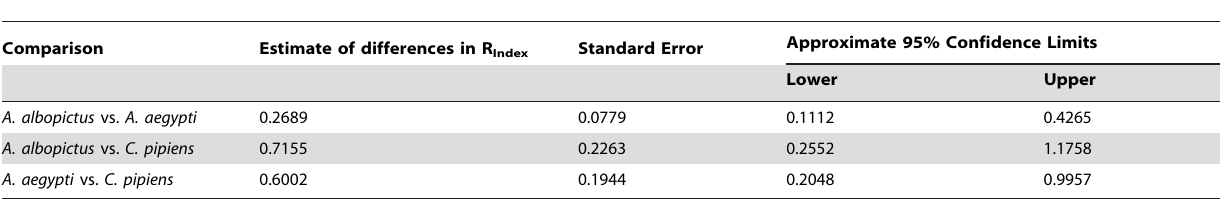
Table 3. Estimates of the differences between Detritus at l 9 =1 (R Index , in dry g litter) for the three mosquito species.